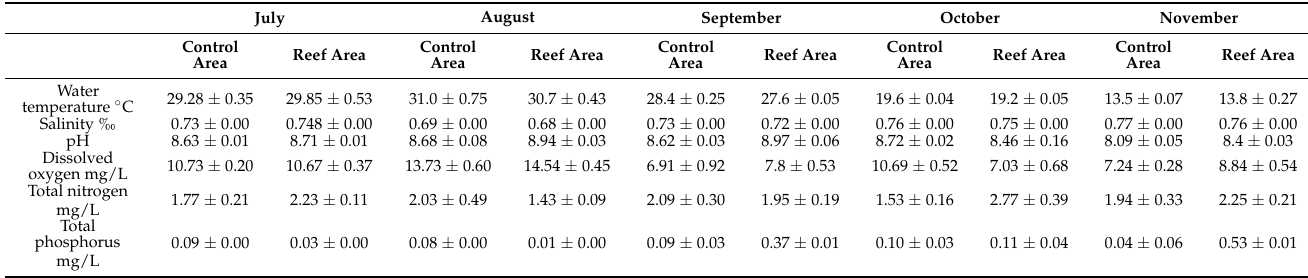
Table 2. Physical and chemical characteristics in Shihoudian Lake.